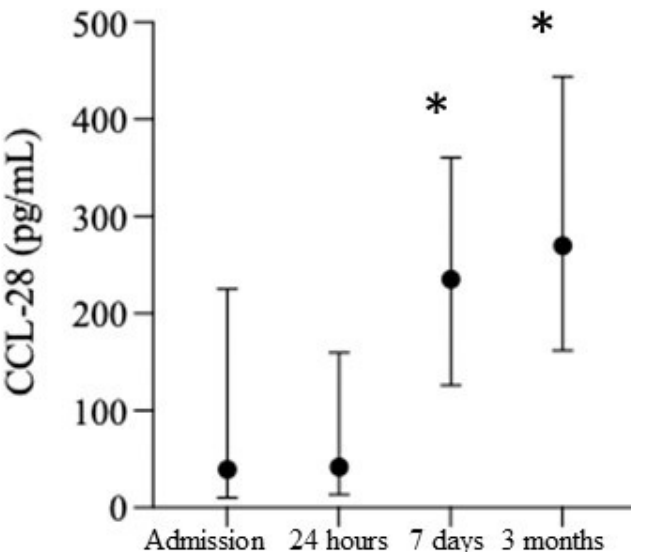
Figure 5. Time course of smoldering vascular inflammation marker after cardiac surgery. CCL-28 levels at baseline, 24 h, 7 days, and 3 months post-surgery.* p < 0.05 .